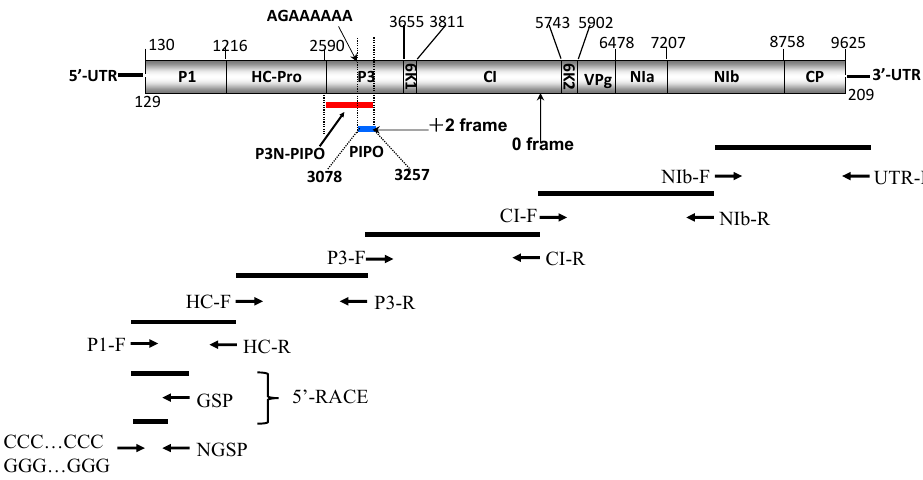
Figure 1. Schematic presentation of TuMV ( Turnip mosaic virus ) full genome cloning strategies. 5 ′ -UTR = 5 ′ -untranslated region; P1 = protein 1; HC-Pro = helper component proteinase; P3 = protein 3; PIPO = Pretty Interesting Potyviridae ORF; 6K1 = peptide 1; CI =cylindrical inclusion protein; 6K2 = peptide 2; VPg = viral genome-linked protein; NIa-Pro= nuclear inclusion a (proteinase); NIb = nuclear inclusion b (viral replicase); CP = coat protein; 3 ′ -UTR = 3 ′ -untranslated region.